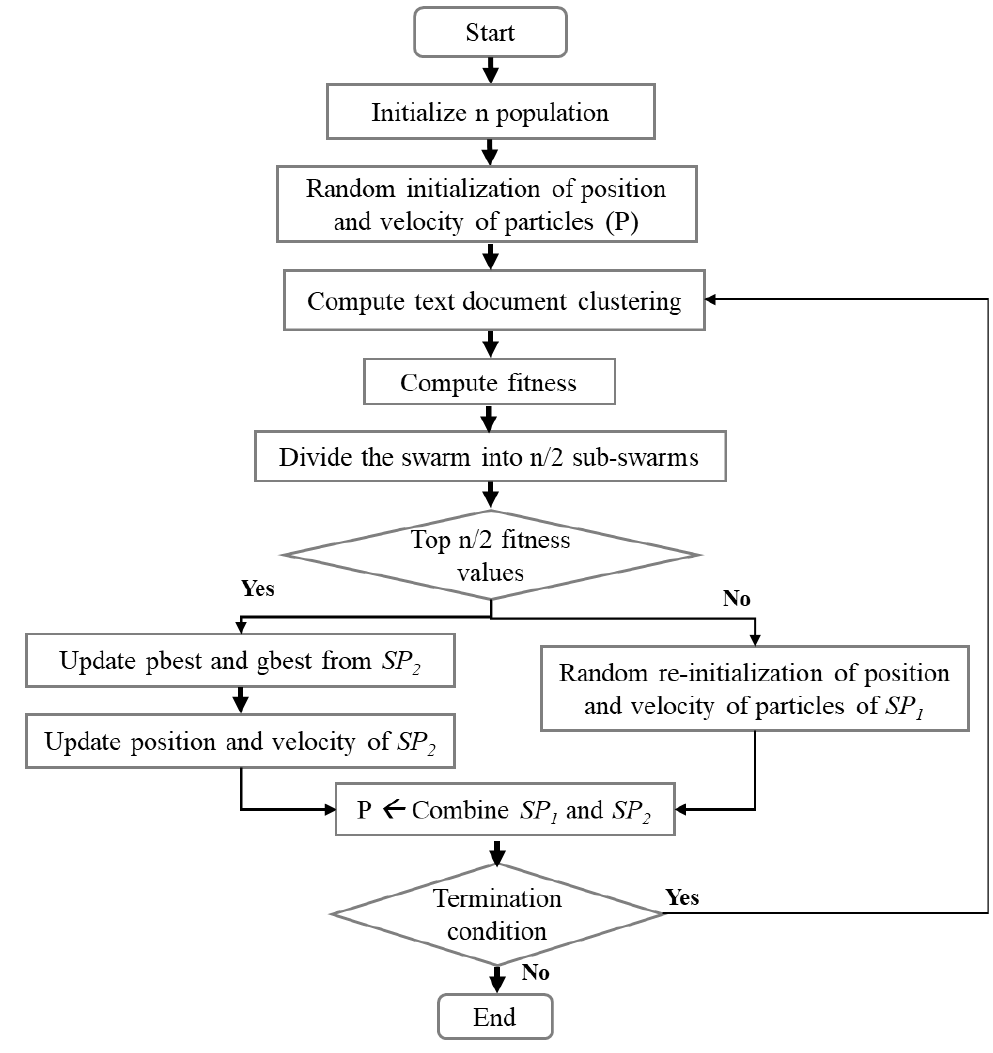
Figure 2. The proposed dynamic sub-swarm for PSO